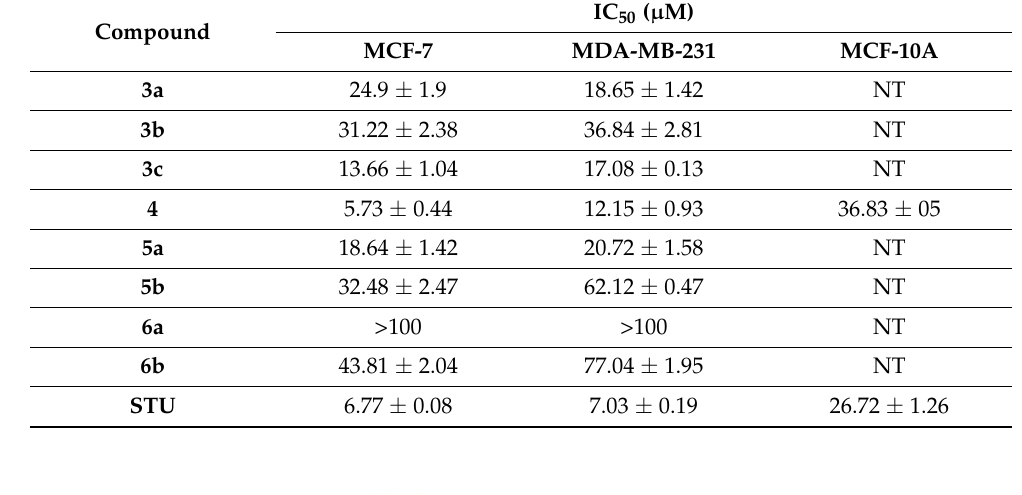
Table 1. Inhibitory activity of compounds ( 3a – c , 4, 5a – b , and 6a – b ) toward the proliferation of various breast cancer cell lines and the epithelial breast cell line.